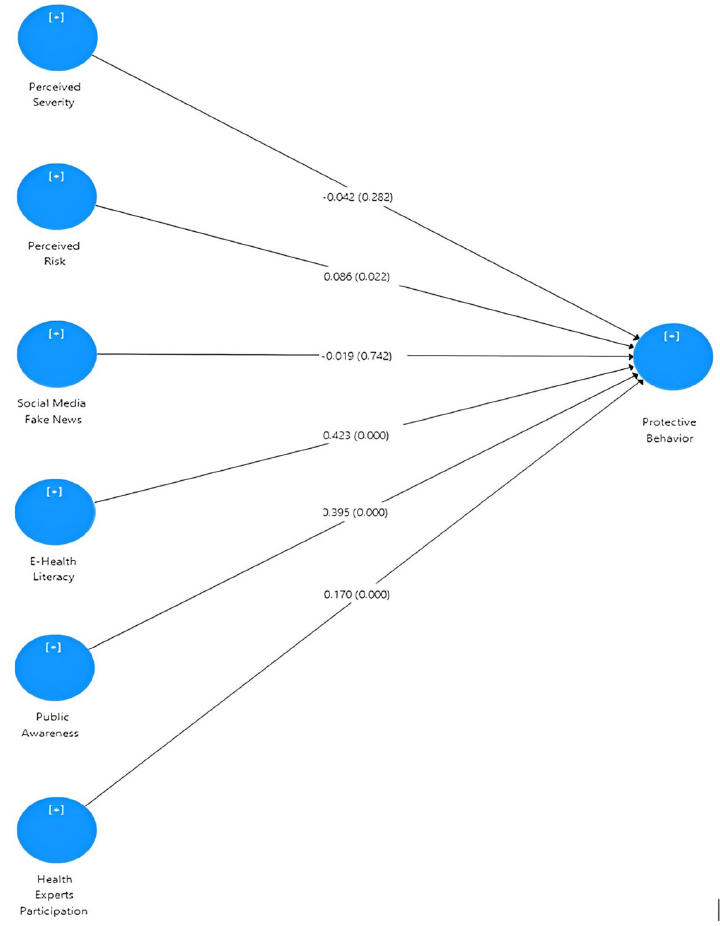
Figure 2. Structural Model for Path Coefficients and p -value. Table 7. Table of Hypothesis Testing (Direct